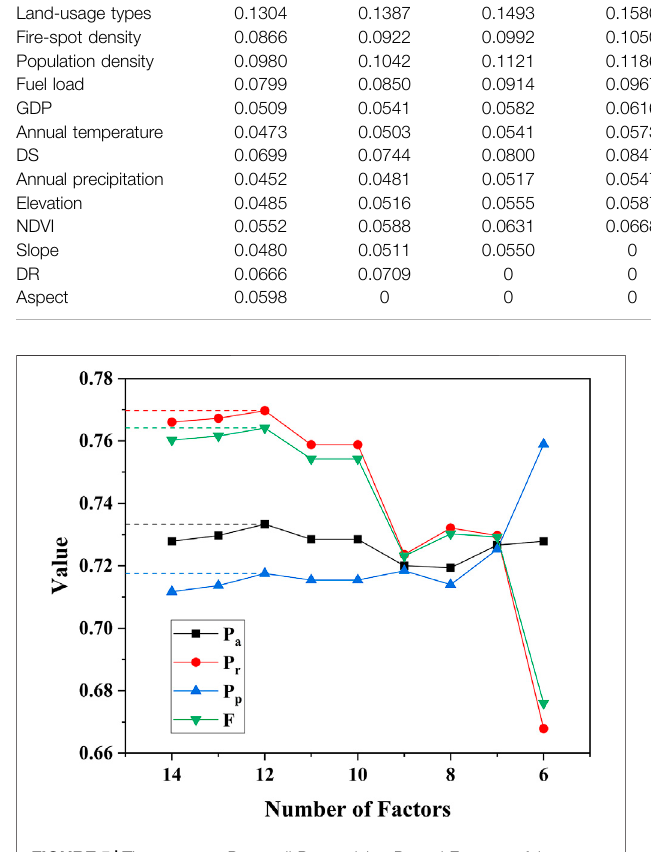
FIGURE 5 | The accuracy P a , recall P r , precision P p and F β score of the model under different factor